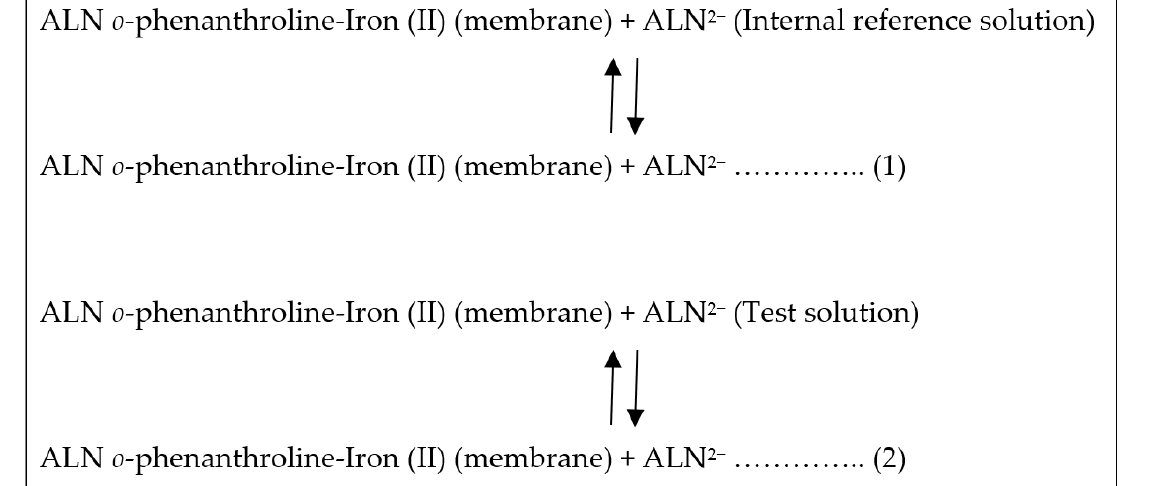
Scheme 1. Schematic representation for the reaction mechanism showing ALN exchange across the fabricated